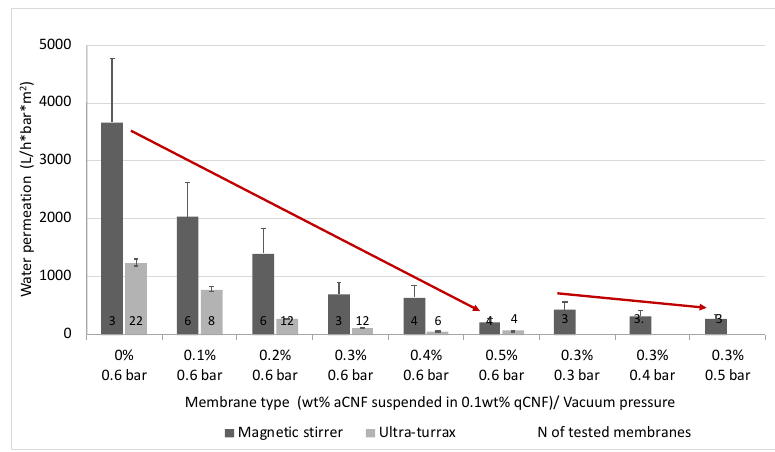
Figure 5. The effect of differently prepared (impregnated with different wt% of amino-hydrophobised CNF/aCNF, pre-suspended in 0.1 wt% quaternised cellulose nanofibrils/qCNF by magnetic stirring or Ultra-turrax) individual (single-layered) membrane on permeation of (300 mL) deionised water by vacuum filtration at different pressures (0.6 − 0.2 bars). The water permeation of the pristine/unmodified membrane could not be measured due to an excessively fast water permeation rate, and is therefore not included. The numerical marks on the bottom of the bars present the number of tested membranes.